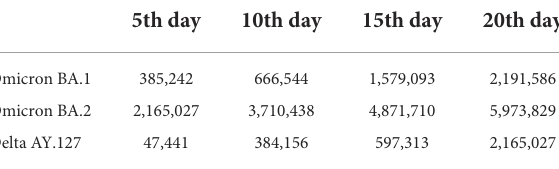
TABLE 1 Number of people living in high-onset-risk communities during the spread of Omicron BA.1, BA.2 and Delta AY.127 in Hong